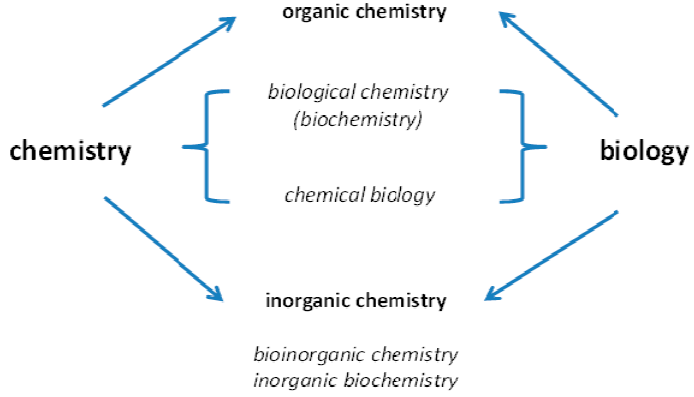
Figure 1. Both chemistry and biology come to bear on investigations of the roles of chemical elements in organisms.